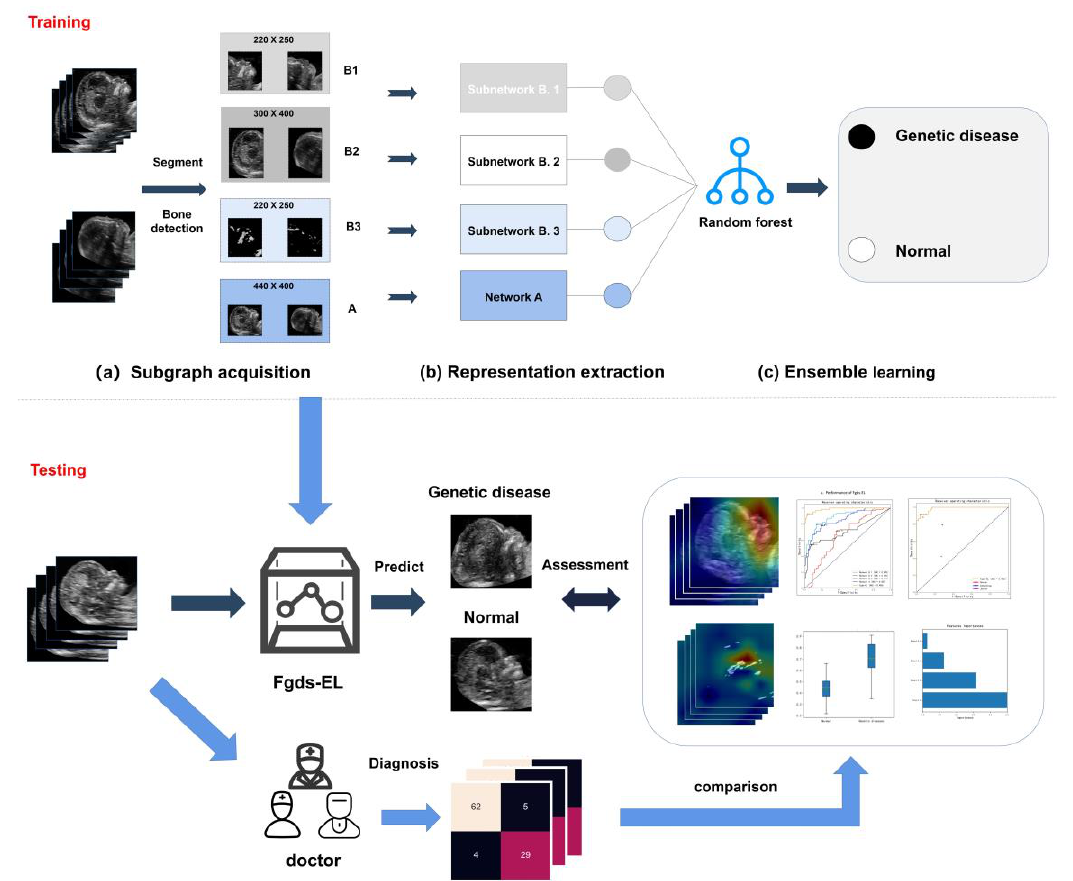
Figure 1. Workflow of the deep learning model for screening fetal genetic diseases. First, the fetal facial image is extracted into four subgraphs by automatic segmentation and bone detection and input into four networks, respectively. Then, the joint prediction probability is obtained using RF on the prediction results of the four networks, and finally, the risk score and heatmap corresponding to this image is obtained.